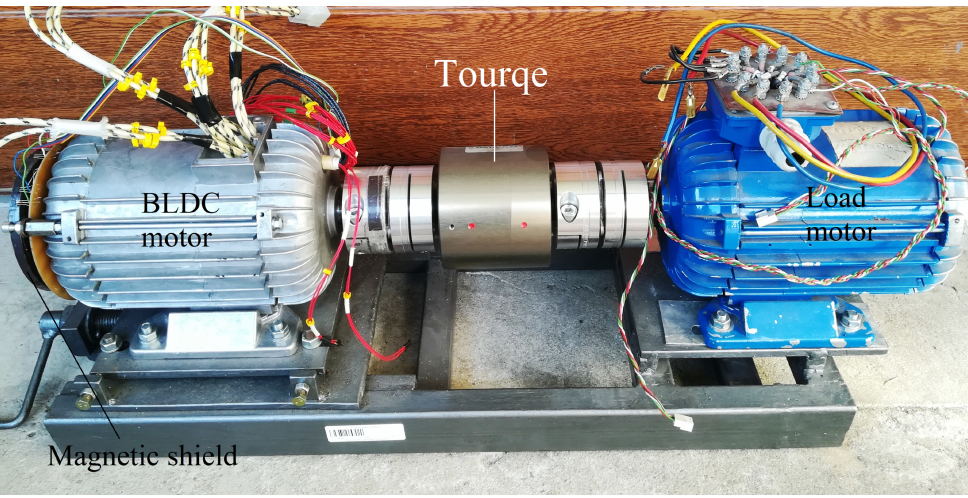
Figure 2. An image showing our developed research stand